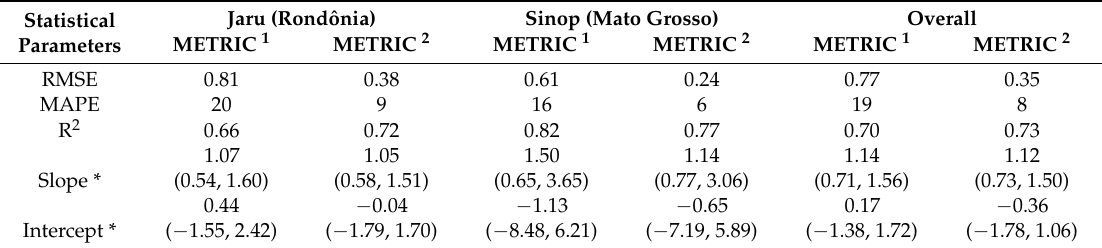
Table 4. Relationships between METRIC ET estimated by two different approaches and flux tower ET in Jaru (Rond ô nia) and Sinop (Mato